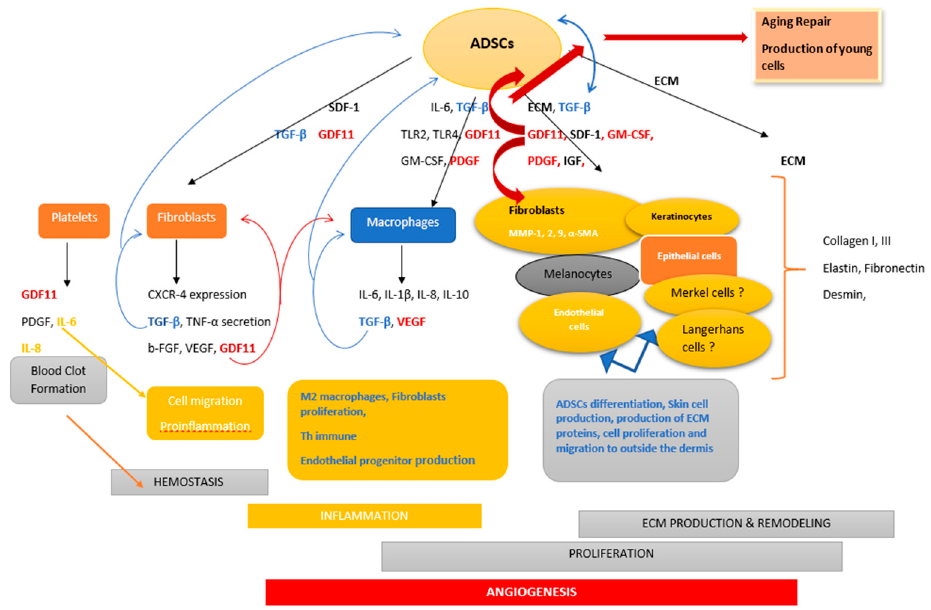
Figure 1. Implication of adipose derived stem cells in the di ff erent phases associated with wound healing and in the rejuvenation process. ADSCs act on fibroblasts, macrophages, and skin cells through their secreted growth factors. GDF11 and TGF- β are present in almost all the phases, amplifying fibroblasts, macrophages, and ADSC secretion, leading to immune responses, cell proliferation, and angiogenesis. However, their interactions are more relevant during proliferation phases where GDF11 might induce TFG- β induction in a spatio-temporal status, in addition to boosting fibroblast proliferation, resulting in the production of skin cells presenting young profiles. GDF11: growth di ff erentiation factor, TGF- β : transforming growth factor, ECM: extracellular matrix, PDGF: platelets derived growth factor, Il-1,6,8,10: interleukin-1, TNF- α : tumor necrosis factor- α , b-FGF: basic-fibroblast growth factor, VEGF: vascular endothelial growth factor, CXCR-4: C motif chemokine receptor 4, SDF-1: stromal derived factor-1, TLR2, 4: toll-like receptor2,4, GM-CSF: granulocyte monocyte-colony stimulating factor, IGF: insulin growth factor, MMP-1,-2, -9: matrix metalloproteinase-1, -2, -9, and α -SMA: α -smooth muscle